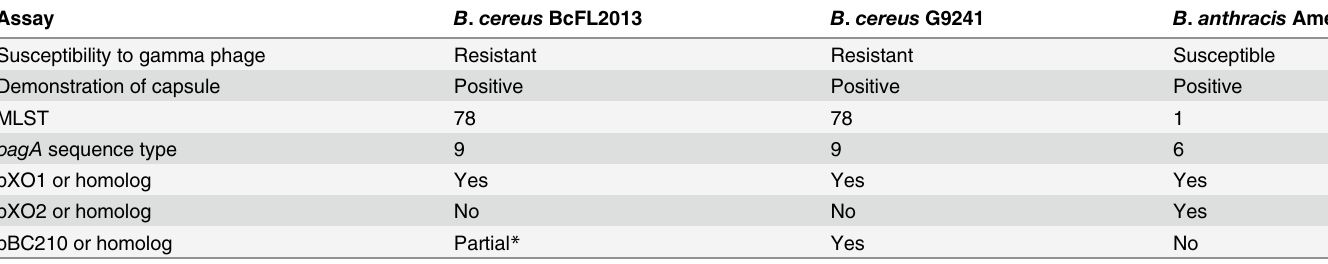
Table 1. Summary of results for testing of B . cereus BcFL2013 compared to B . cereus G9241 and B . anthracis Ames.